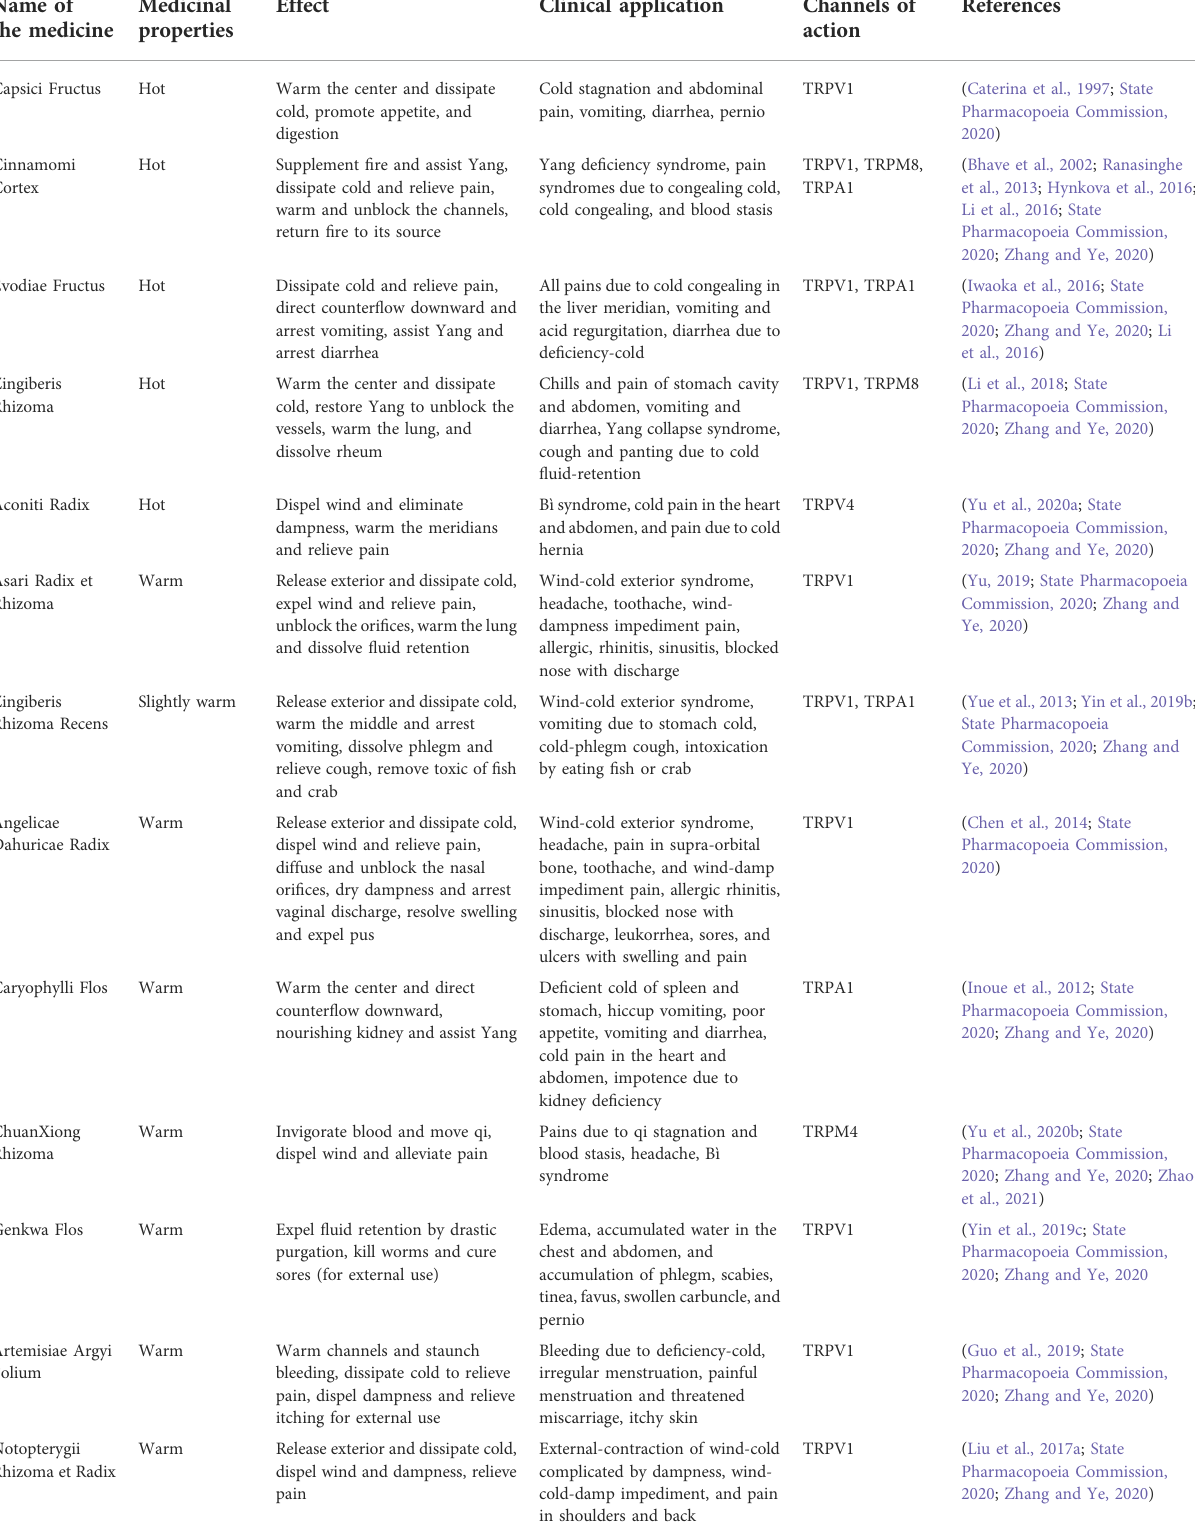
TABLE 2 List of Chinese herbal medicines that act on TRP channels Name of Medicinal the medicine